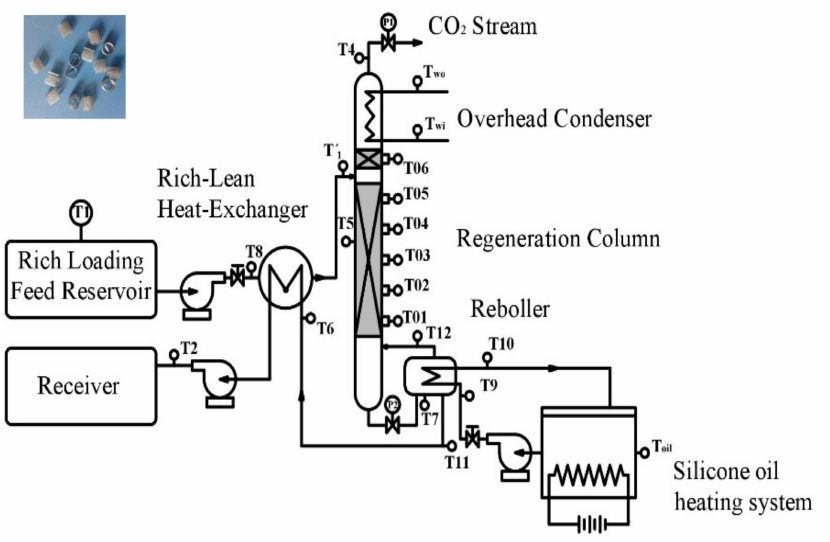
Figure 3. A stripping process with θ -ring packings conducted in this work [17]. T1: Inlet temperature of rich loading; T2: Temperature at outlet of heat exchanger; T4: Out temperature at the top of cooler; T5: Temperature of bed; T6: Liquid temperature at the inlet of heat exchanger; T7: Reboiler temperature; T8: Inlet temperature of rich loading; T9: Oil temperature at the inlet of reboiler(T in ); T10: Oil temperature at the outlet of reboiler(T out ); T11: Outlet temperature the reboiler; T12: Steam temperature; T wi : Inlet temperature of cooling water; T wo : Outlet temperature of cooling water; T (cid:48) 1: Inlet temperature at top of the column; P1: Pressure valve at the top of tower; P2: Pressure valve at the bottom of